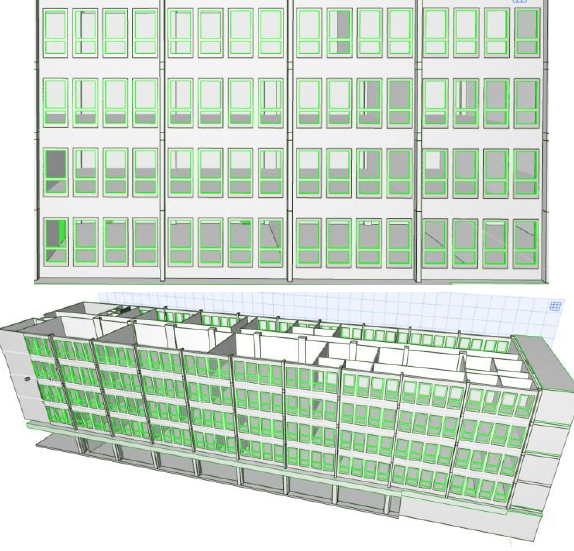
Fig. 7: The modelling process by linking the